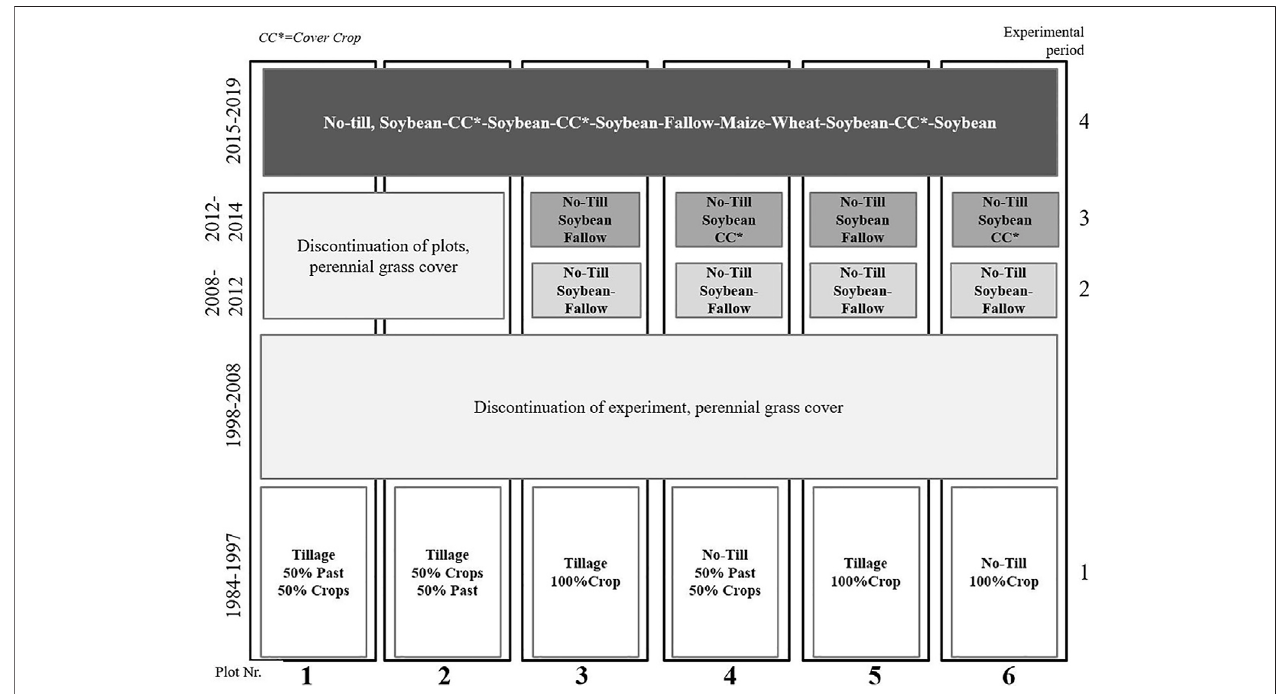
FIGURE 1 | Experimental design of the Wischmeier plots and their history of soil use and management since the experimental onset in 1984.